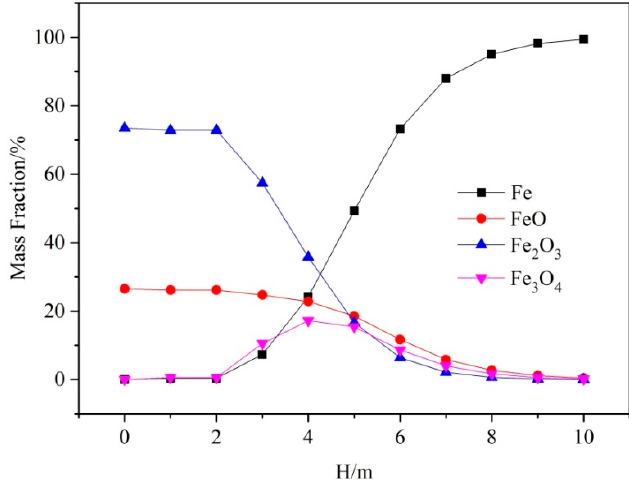
Figure 9. Mass fraction of Fe 2 O 3 , FeO, Fe 3 O 4 , and Fe at different heights of the reaction shaft